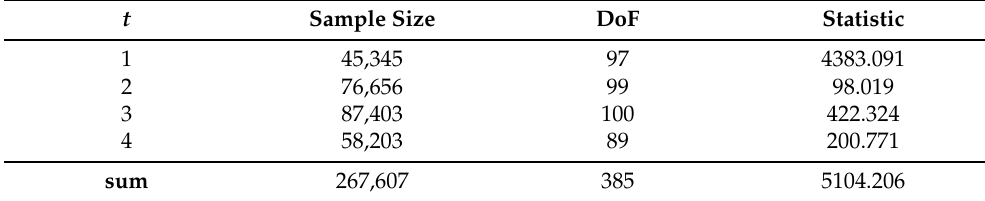
Table A4. Test results for time homogeneity of the transition probabilities of the first order Markov chain with 10 states. The columns from left to right list the season, the sample size in each season, the degree of freedom, and the statistics,